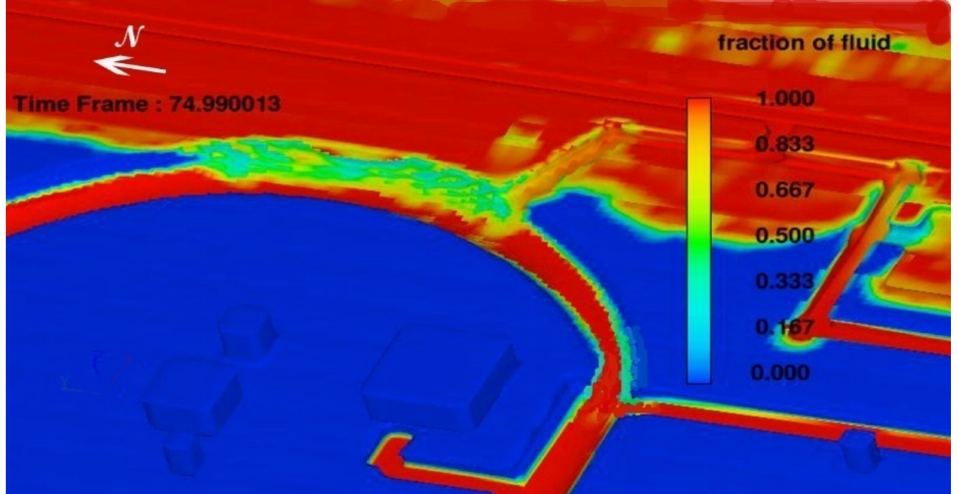
Figure 6. Post rainy season fluid fraction detail from FLOW-3D calculations of the east arm of the perimeter drainage channel showing the perimeter drainage channel’s surface walls conducting seepage water to the saturated bottom of the perimeter drainage channel and the start of progressive surface drying for Case 1 conditions.